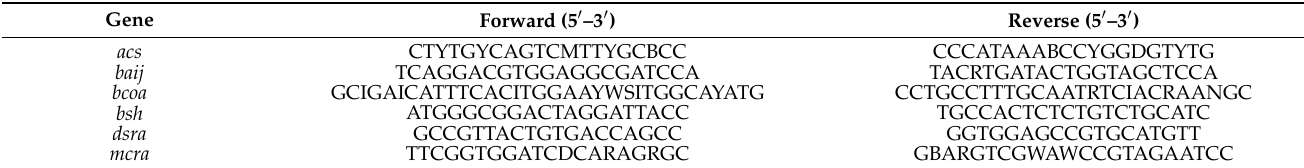
Table 4. Primers used to quantify bacteria gene copy